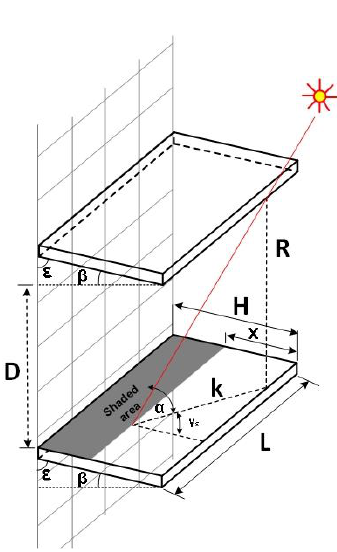
Figure 11. Shaded area on bottom collector.